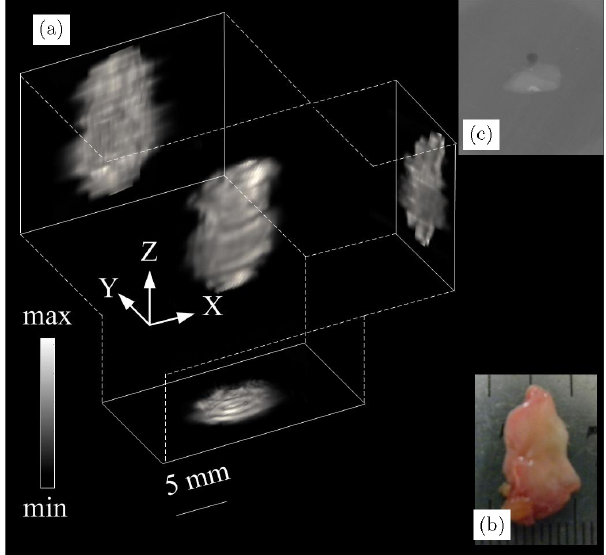
Fig. 5. (a) Three-dimensional thermoacoustic imaging of a human breast tumor. (b) Photographs of breast tumor after surgery. (c) X-ray image of breast tumor in top